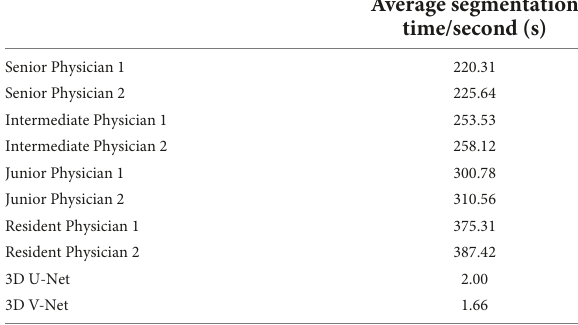
TABLE 6 Average time for manual segmentation and model segmentation of auditory ossicles.